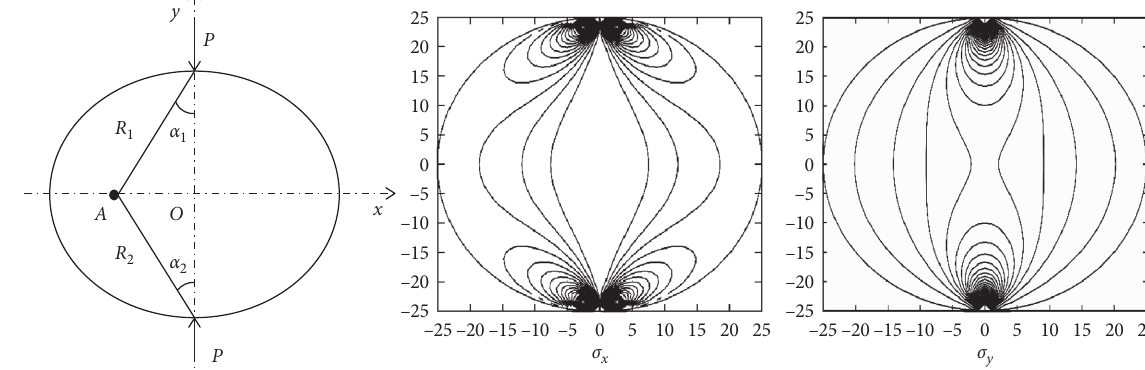
Figure 6: Stress analysis diagram of the Brazilian disc and the distribution of the stress analytic solution.